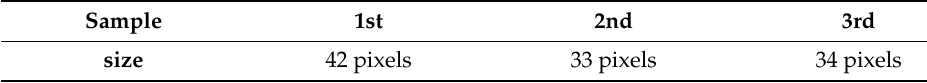
Figure 4. Results of stepwise processing using image graphics. Table 3. The maximum spot size obtained in three sets of